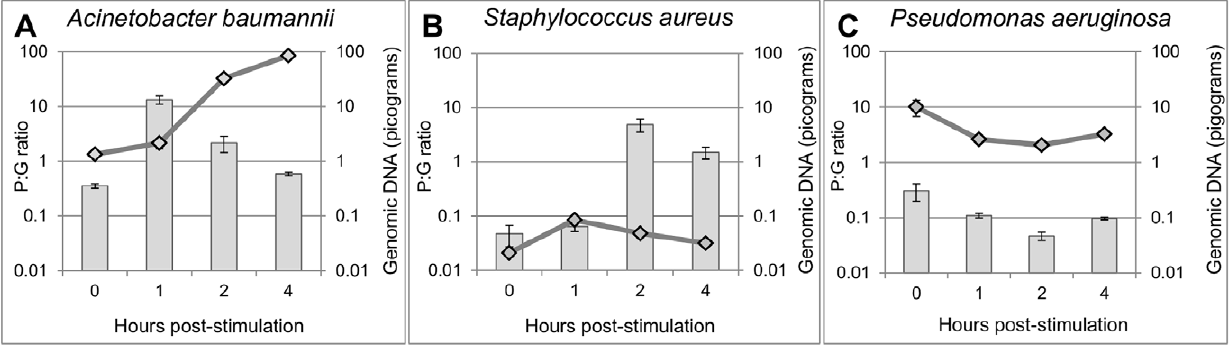
Figure 2. Ratiometric pre-rRNA analysis of A.baumannii , S.aureus , and P.aeruginosa cells in serum. A–C: Analysis of cells that had been held in serum for 7 days. Nutritional stimulation was initiated by suspending cells in pre-warmed TSB, and samples taken after 0, 1, 2, and 4 hours were subjected to RT-qPCR and qPCR to quantify pre-rRNA and gDNA, respectively. The same primers were used to amplify gDNA and cDNA generated from pre-rRNA. Ratios of pre-rRNA to gDNA (P:G; bars) are means and SDs of nine ratiometric permutations from three technical replicates of each sample type. Quantity of gDNA (lines) are means and standard deviations of the three gDNA measurements. Viable cell densities of A. baumannii, S. aureus, and P. aeruginosa, respectively, in serum were 9.0 6 10 8 , 9.7 6 10 5 , and , 1 6 10 2 CFU/mL. From separate gDNA standard curves consisting of $ five points each, qPCR efficiencies were calculated [10 ( 2 1/slope) 2 1] to be between 0.913 and 0.959. A replicate experiment (Figure S1) yielded similar results for all three organisms.